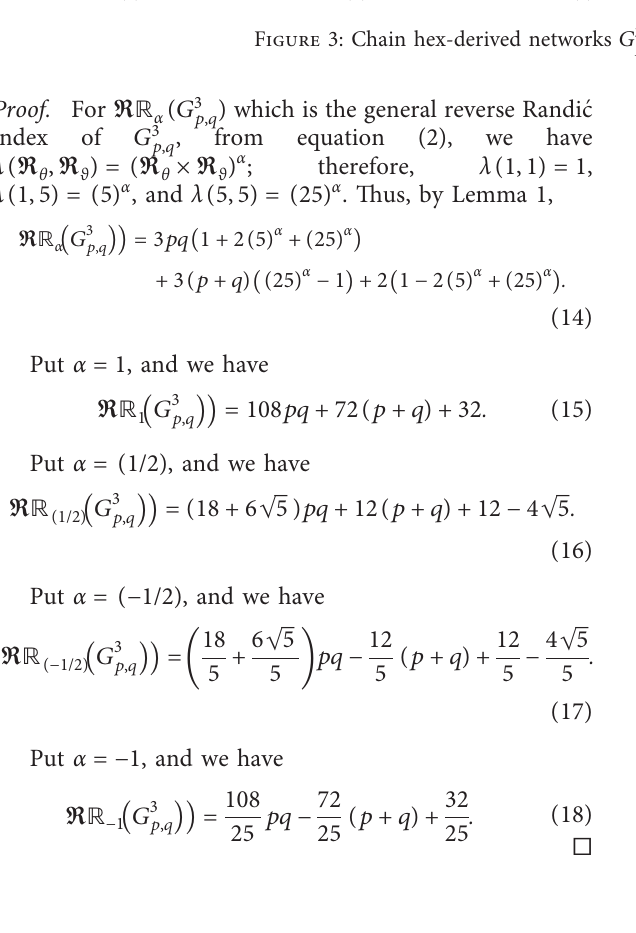
Figure 3: Chain hex-derived networks G 3